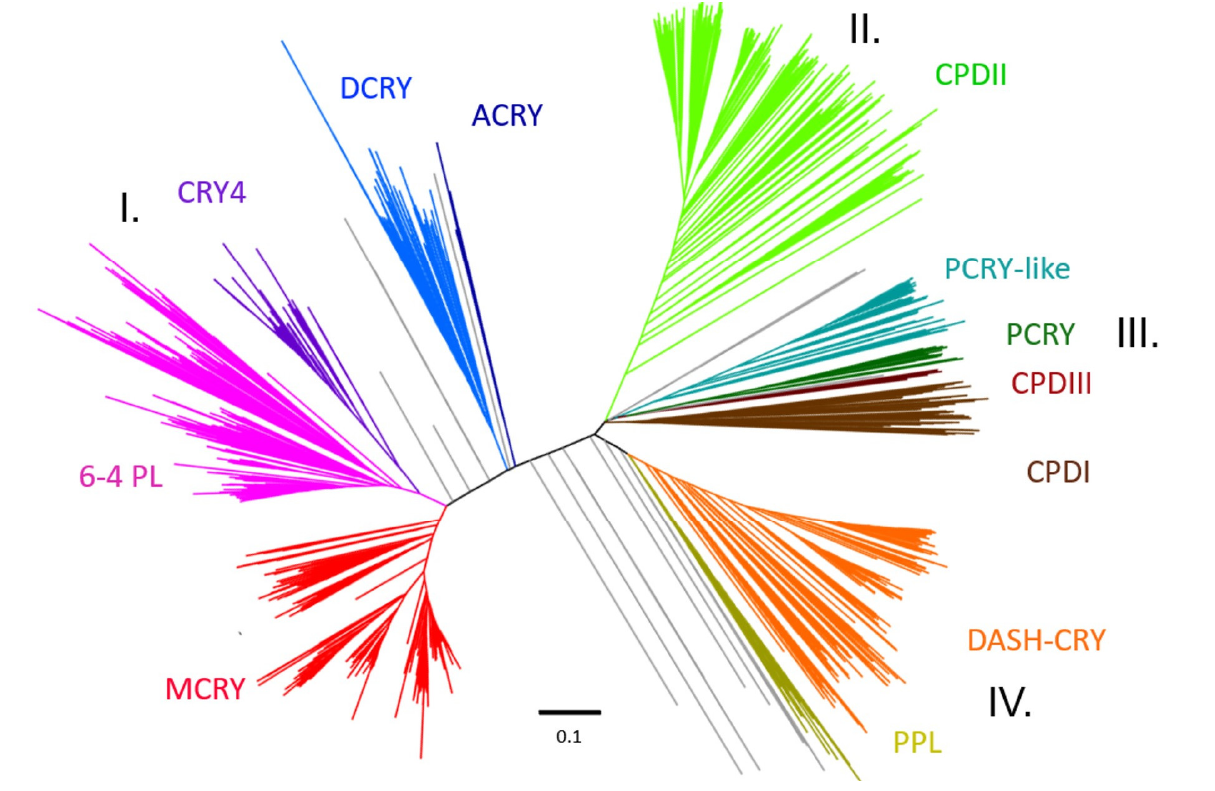
Figure 2. Unrooted phylogenetic tree revealing the four main clusters formed by CRY/PL family members. The 6-4 photolyase cluster (I) includes the mammalian type MCRY (red), the Drosophila- type DCRY (blue), CRY4 involved in magnetoreception (purple) and the 6-4 photolyase itself (pink). The CPDII cluster (II) consists of CPDII photolyases (light green). The CPDI/III cluster (III) includes the CPDI (dark brown) & CPDIII photolyase (light brown), the plant cryptochrome PCRY (dark green), and the PCRY-like (turquoise). The DASH cluster (IV) consists of DASH-CRY (orange) and the plant photolyase PPL (yellow). Branches we could not precisely assign are shown in grey.